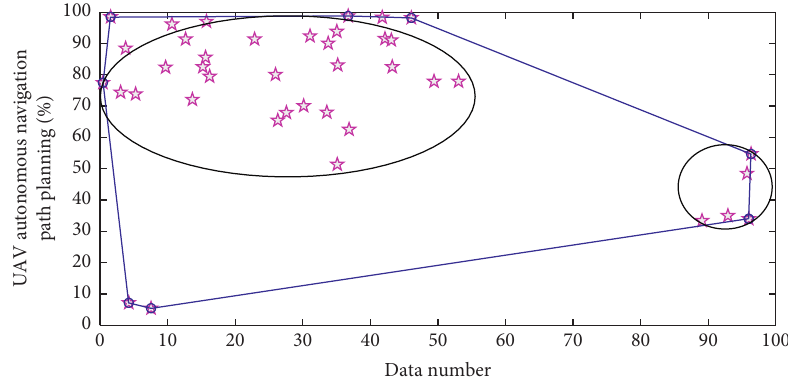
Figure 4: UAV autonomous navigation path